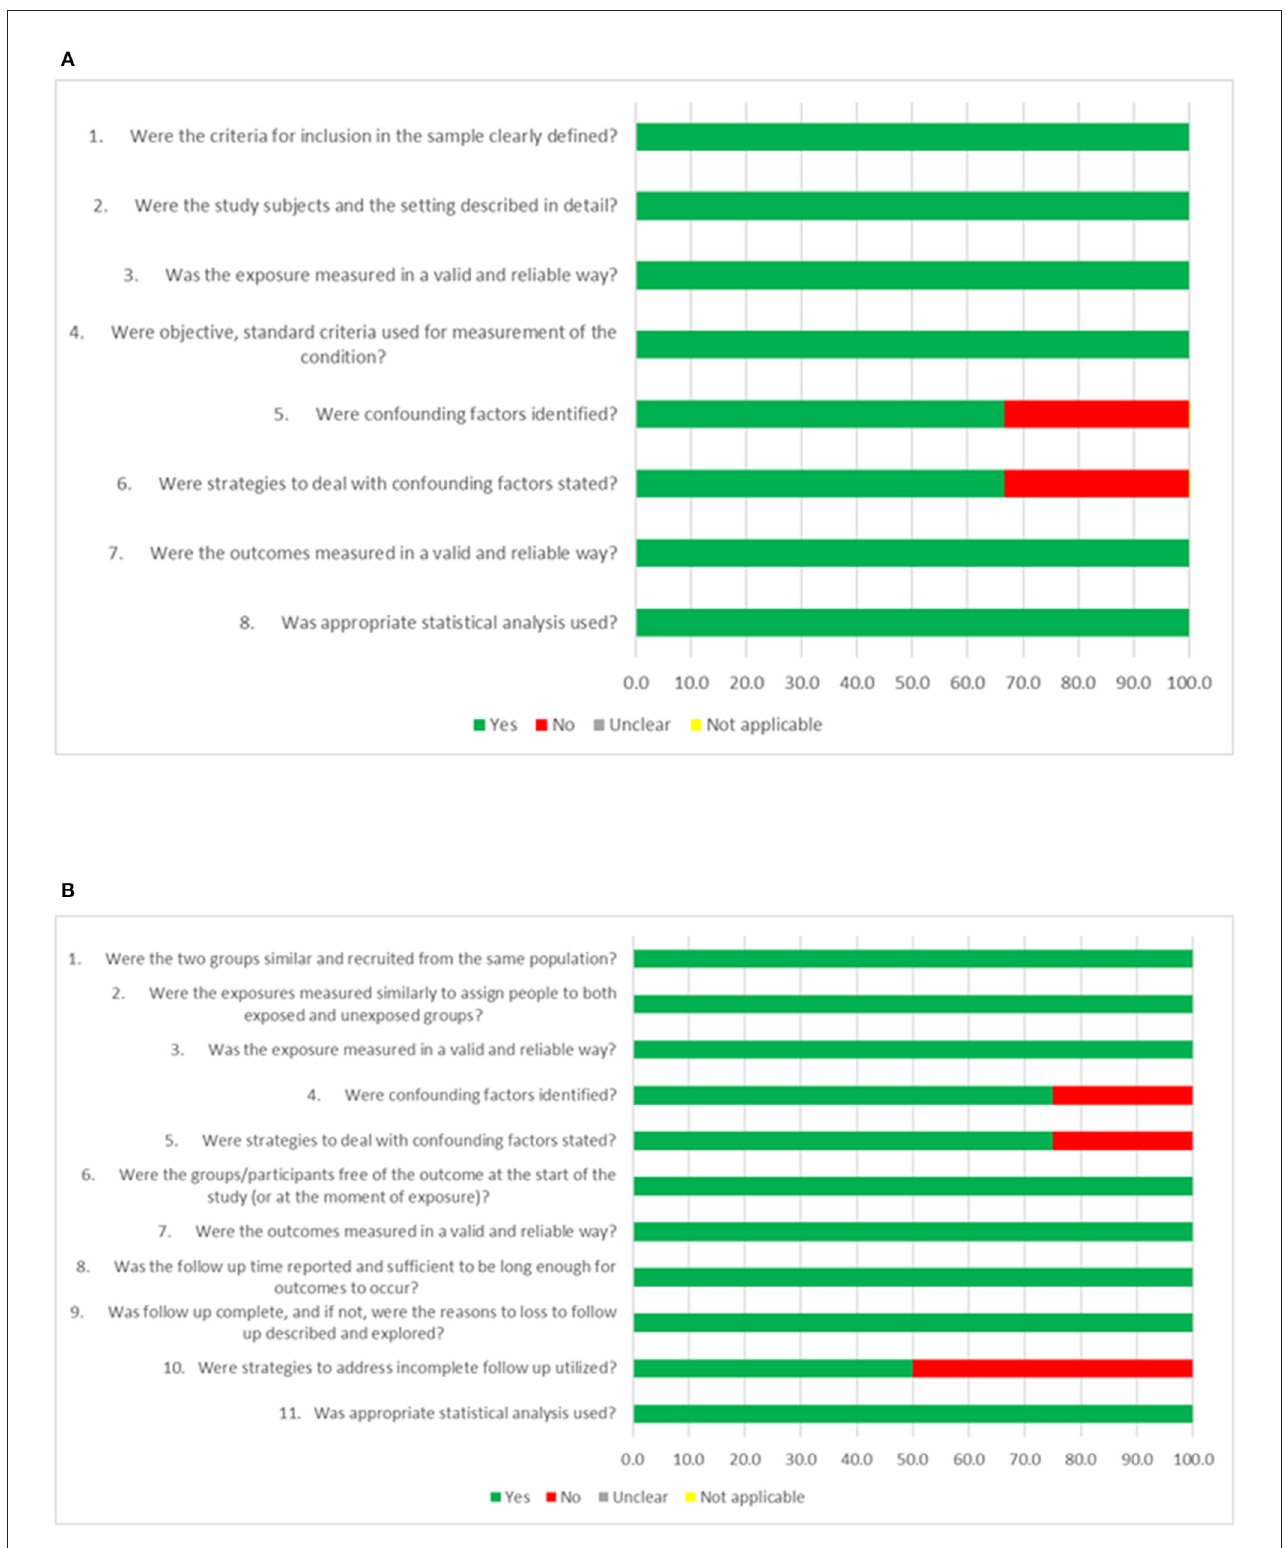
FIGURE4 Analysis of risk of bias according to the Joanna Briggs Institute (JBI) critical assessment tools for cohort (A) , and cross-sectional (B) studies.